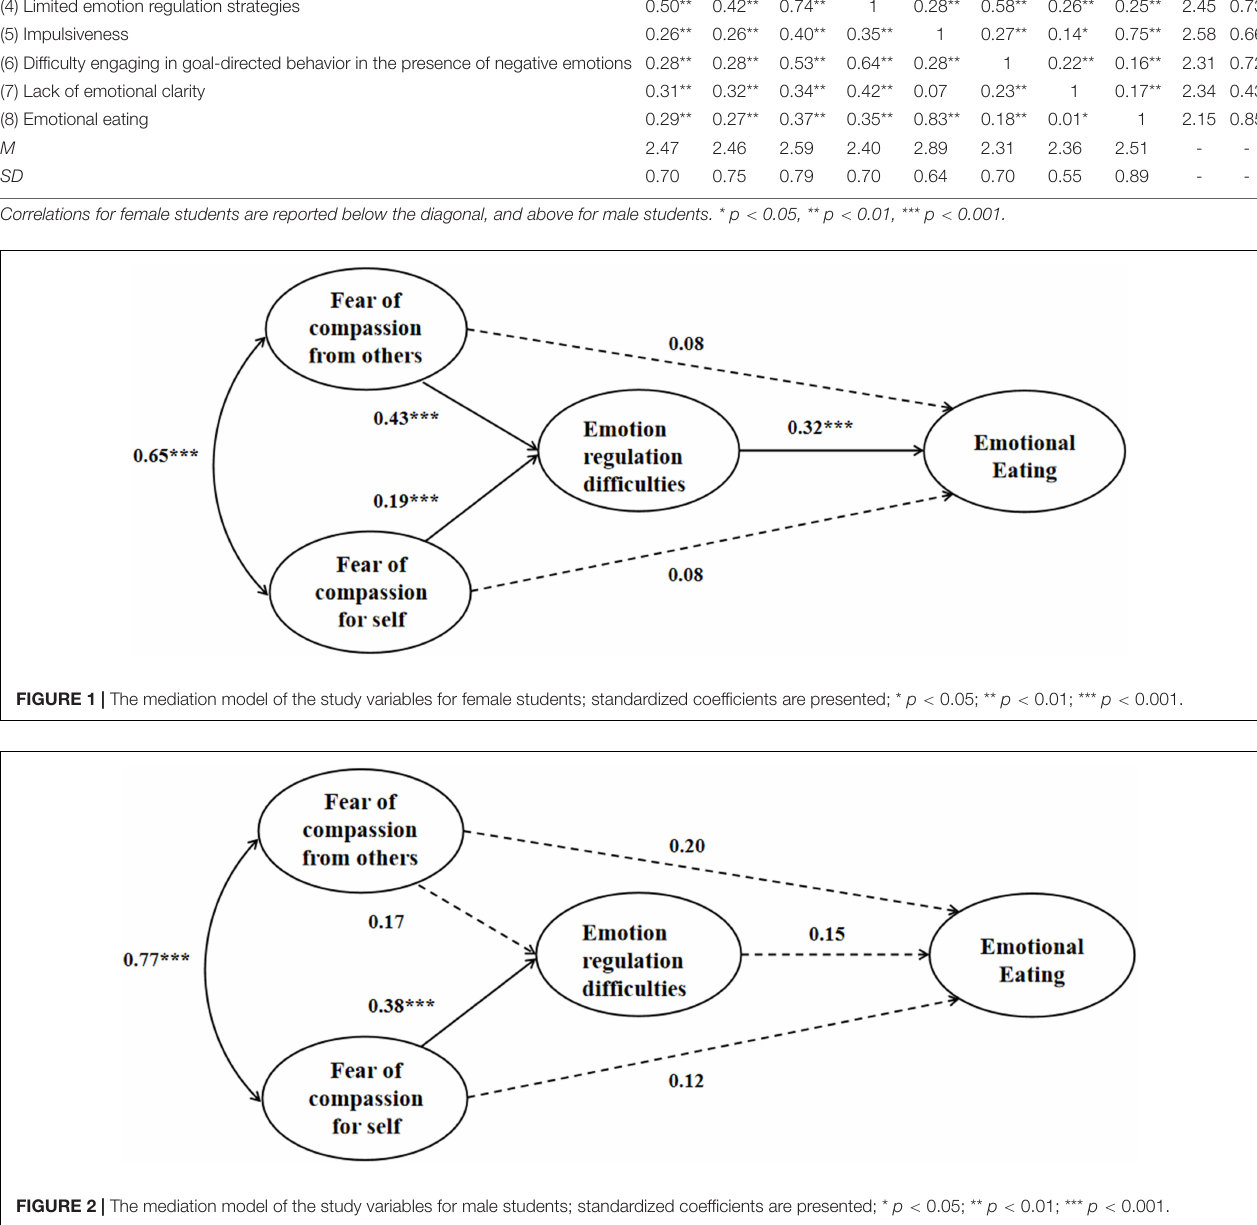
and female. Specifically, there was significant difference in